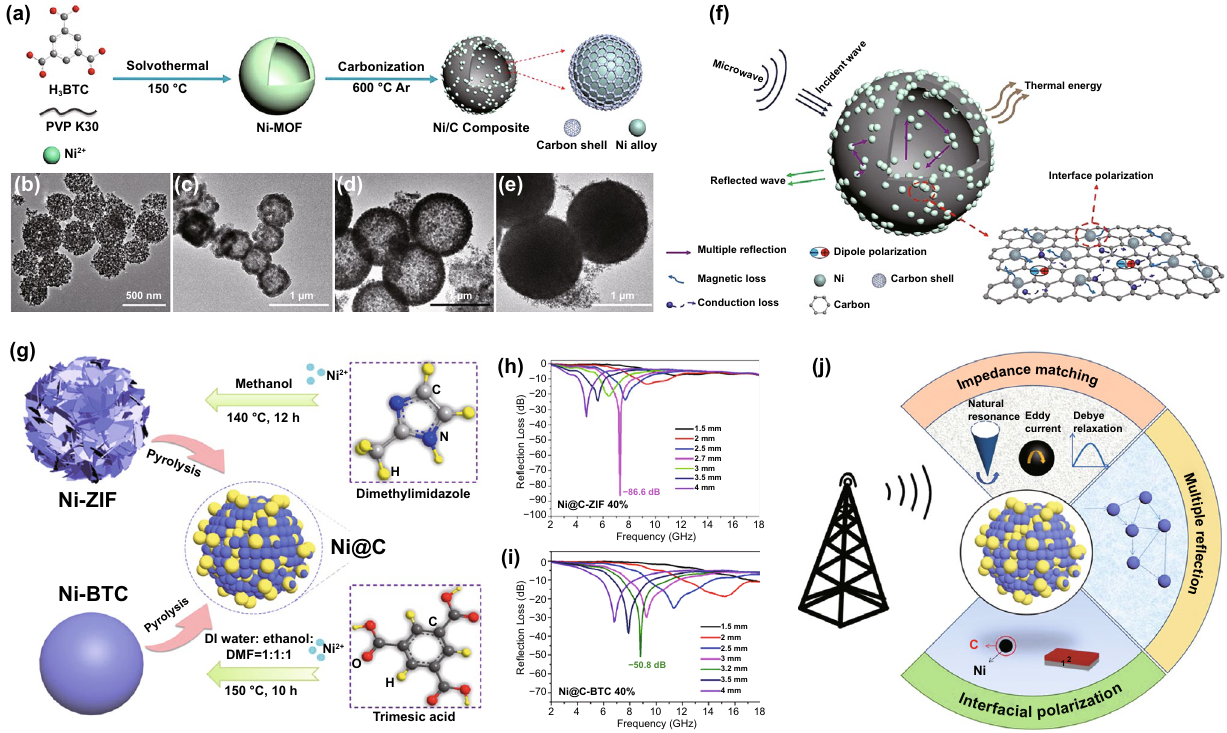
Fig. 6 a Diagrammatic sketch of the preparation process of Ni/C composites. b–e TEM images of four kinds of Ni/C composites. f Illustration of MA mechanism for Ni/C composites. Reprinted with permission from Ref. [41]. g Schematic illustration of the fabrication process of Ni@C microspheres. RL-f curves of h Ni@C-ZIF and i Ni@C-BTC. j Schematic diagram of MA mechanism for Ni@C microspheres. Reprinted with permission from Ref.